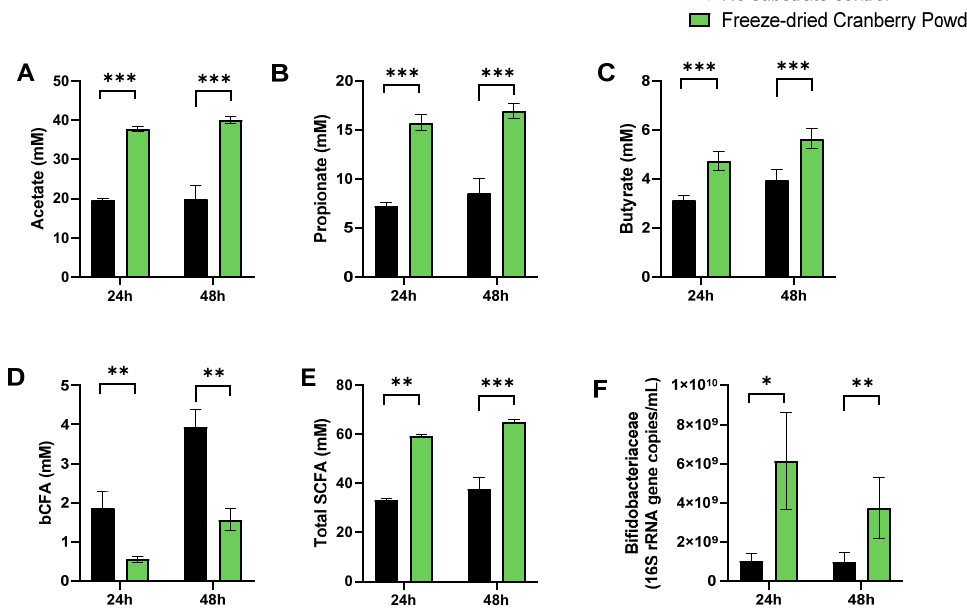
Figure 3. Effect of FCP on levels of acetate ( A ), propionate ( B ), butyrate ( C ), bCFA ( D ), total SCFA ( E ) and Bifidobacteriaceae ( F ), upon incubation with a human faecal microbiota derived of five different human donors. All conditions were tested in technical duplicate. The data are presented as the average value (± SEM) across all donors and replicates ( n = 10). Statistical differences due to treatment were indicated by */**/*** (0.01 < p < 0.05/0.001 < p < 0.01/ p < 0.001). Simulated Proximal and Distal Colon of Three Human Adults Tested in the Triple-M-SHIME (Test 2) Given the consistent effects of a single dose of FCP on the simulated human gut microbiota during test 1, any of the five donors tested could have been used for test 2 during which the effect of repeated administration of FCP was investigated. To investigate potential interpersonal differences, it was opted to test FCP fermentation for more than one donor during test 2 (donors